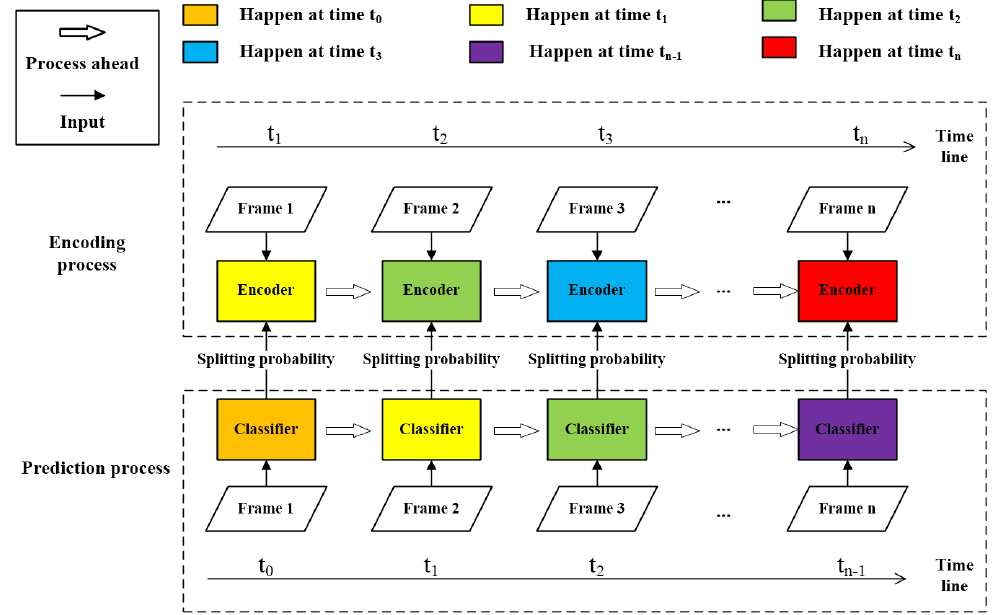
Figure 3. Framework of the proposed frame-wise beforehand prediction. Frame n represents the n -th frame in a video sequence to be encoded. t n represents the time t n , at which the process happens. Blocks in the same color happen at the same